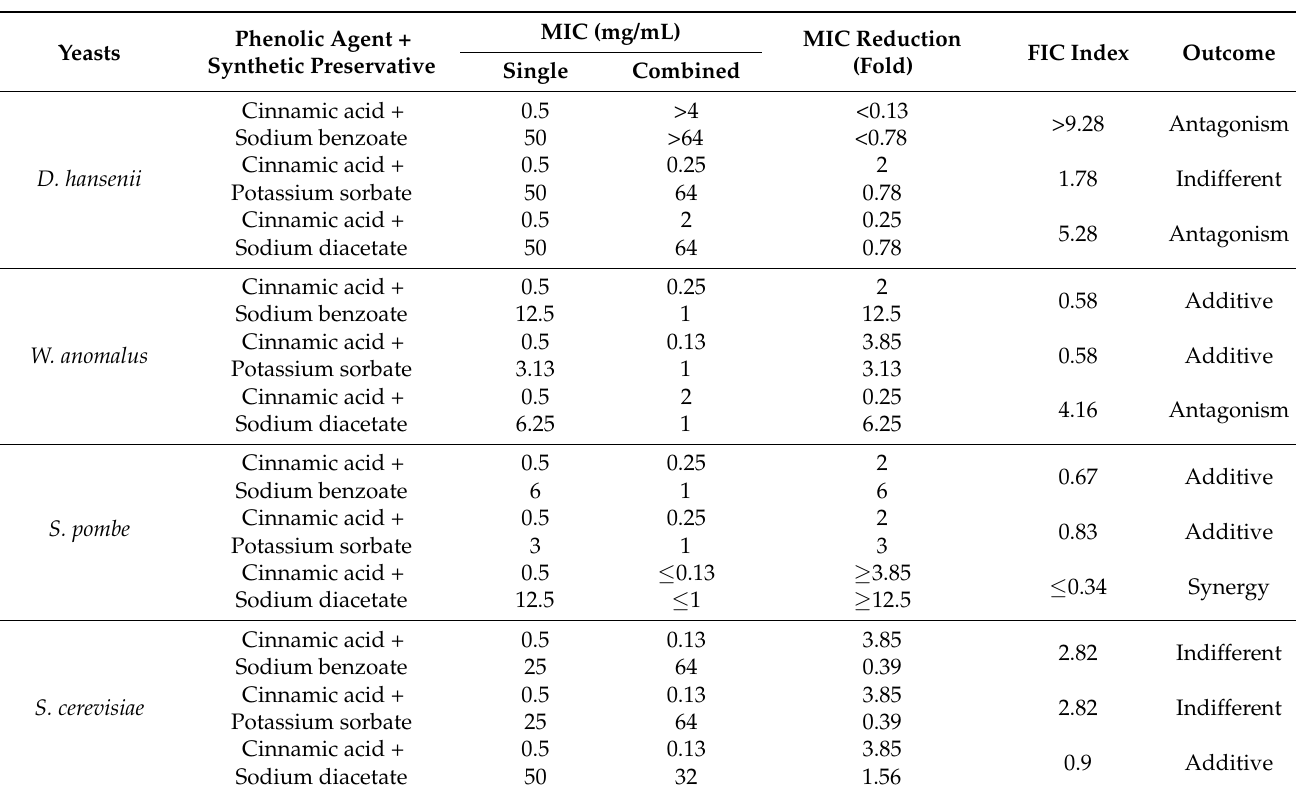
Table 3. Effect of combination of cinnamic acid and synthetic preservatives on planktonic growth of food spoilage